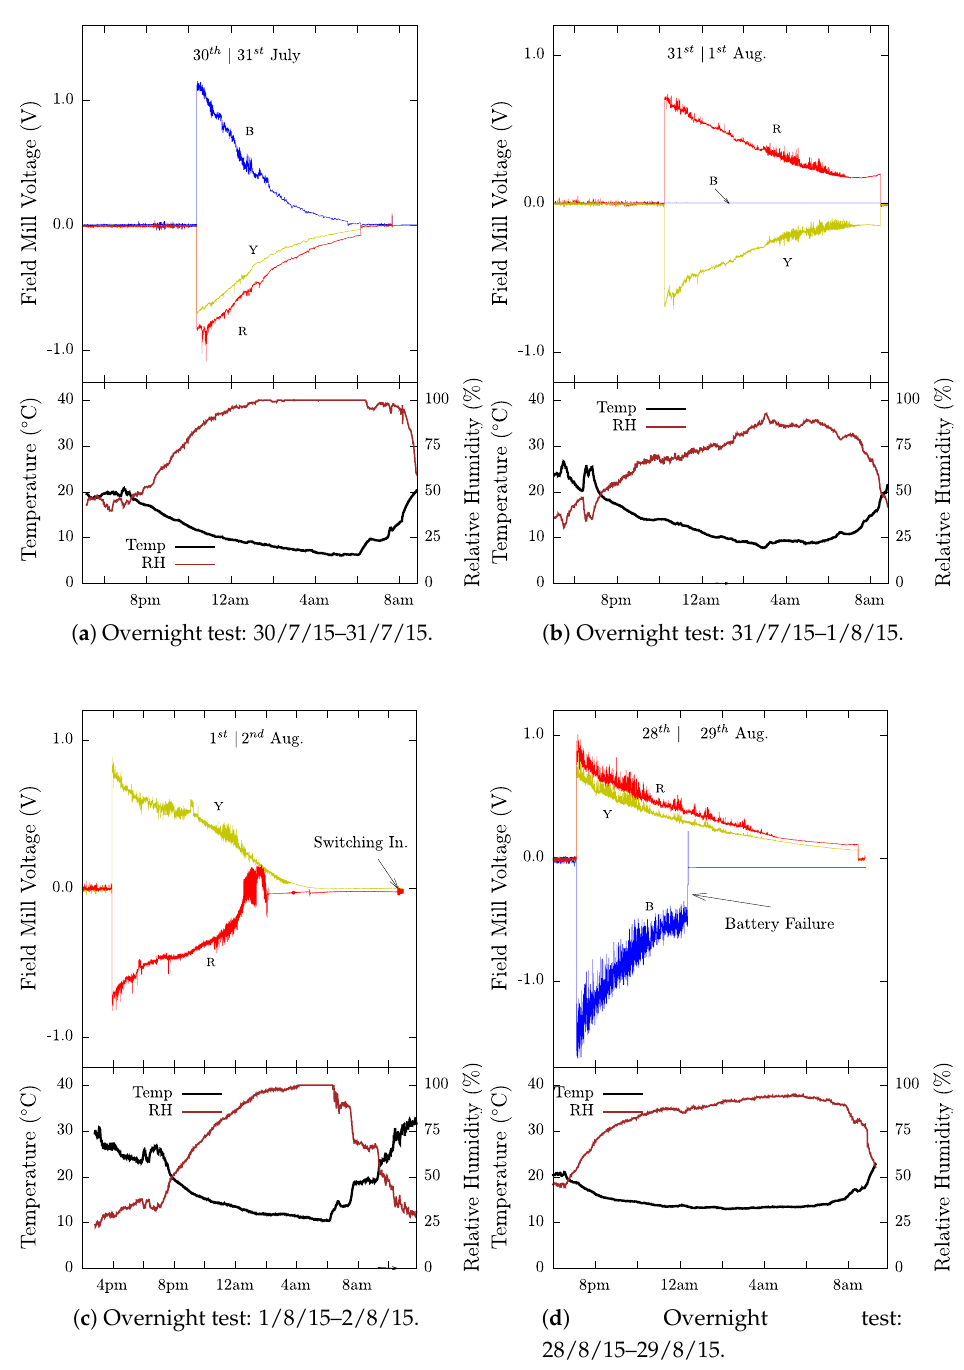
Figure 8. Recorded Field Mill voltages for each phase (R = Red, Y = Yellow, B = Blue) and RH/temperature plotted on the same time